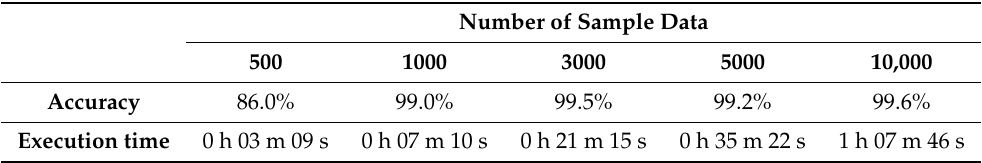
Table 3. Normal/abnormal diagnosis result of array antenna by number of sample data.